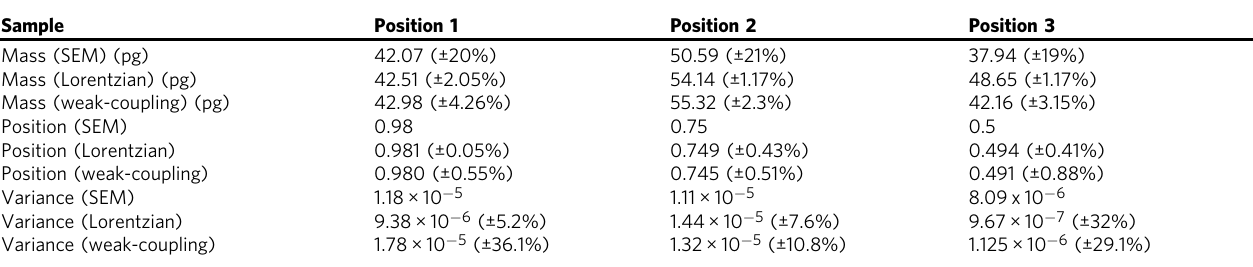
Table 1 Mass, position and variance of the deposited mass evaluated by SEM and calculated with the inertial imaging approach using (primary) Lorentzian resonance and weak-coupling peak shifts